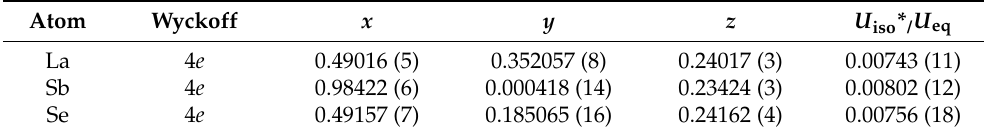
Table 2. Room temperature crystal structure determined by single crystal XRD. Space group: P 21/ c . a = 4.2512 (1) Å, b = 18.4342 (2) Å, 6.0153 (1) Å. β = 134.978 (3)º.